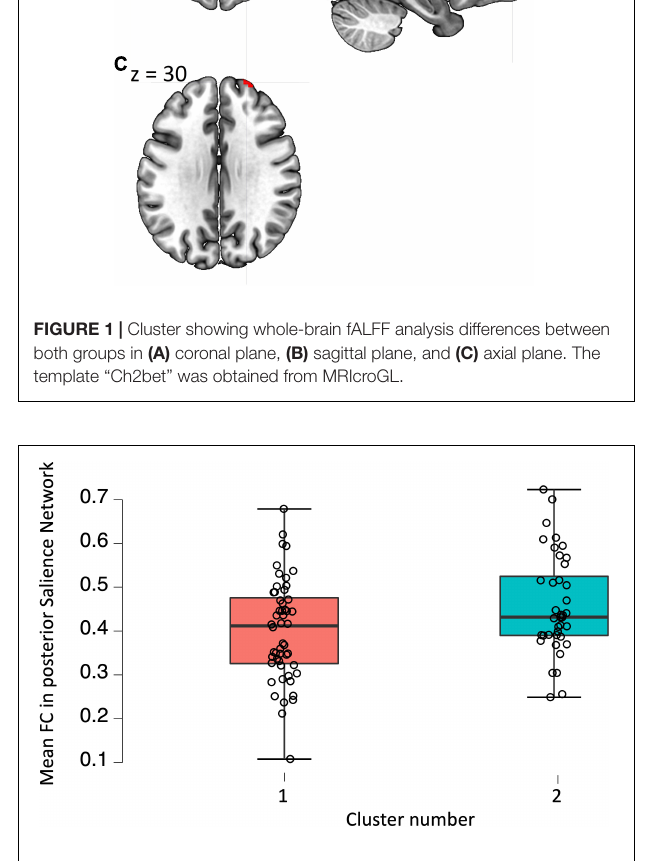
FIGURE 2 | Boxplot showing raw functional connectivity values in posterior salience network for groups with low and high